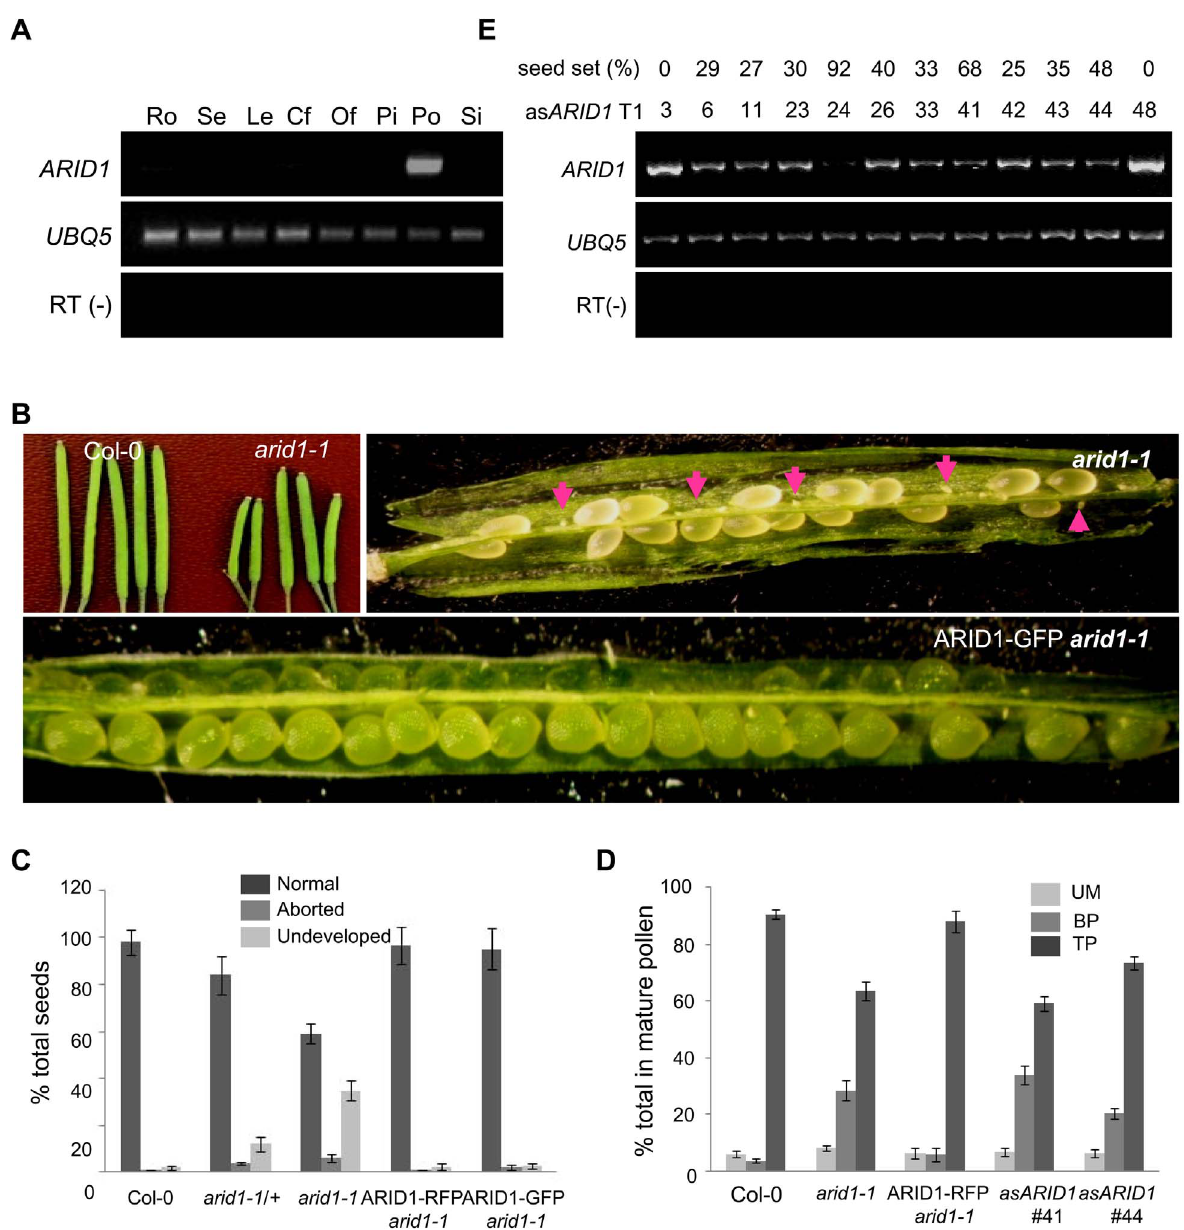
Figure 1. Specific expression of ARID1 in pollen and disruption of ARID1 results in defective sperm cell formation. (A) Expression of ARID1 by RT-PCR. Ro, roots; Se, seedlings; Le, leaves; Cf, closed flower buds; Of, open flowers; Pi, unpollinated pistils; Po, mature pollen; Si, siliques. The RT ( 2 ) control PCR was performed with UBQ5 primers. (B) Representative siliques of WT and arid1-1 and complementation test. Undeveloped ovules are indicated with arrows. (C) Percentage of normal seeds (dark grey), aborted seeds (lighter grey), and undeveloped ovules (lightest grey) from self-pollinated plants are shown. Error bars represent standard deviation from the mean. (D) Seed set analysis in antisense ARID1 transgenic plants. Numbers in the bottom row represent individual T1 lines, and the corresponding numbers in the top row indicate the percentage of reduced seed set in each line. The gel shows the expression of ARID1 as assessed by RT-PCR analysis. (E) Distribution of unicellular microspores (UM, lightest grey), bicellular pollen (BP, lighter grey), and tricellular pollen (TP, dark grey) in mature anthers. At least 600 pollen grains were stained with DAPI and used for statistical analysis; Error bars represent standard deviation from the mean. expression of these genes was disturbed in arid1-1 . Of these, only in both bicellular pollen (Figure 2B, upper panels, yellow arrows) and mature pollen (Figure 2B, lower panels, yellow arrows). Since DUO1 mRNA levels were reduced in arid1-1 (Figure 2A), suggesting that ARID1 positively regulates DUO1 at the DUO1 is one of the targets of miR159 [12], we examined transcriptional level, either directly or indirectly. DUO1 expression MIR159 expression in the arid1-1 mutant by qPCR, but found no was also reduced in the antisense ARID1 plants with reduced seed change in miR159 levels (Figure S2B). As we recently showed that set (Figure S2A). We also crossed a DUO1-RFP reporter into Anaphase Promoting Complex 8 (APC8) is involved in CYCB1 regulation at both the transcriptional level and protein degrada- arid1-1 and saw that the DUO1-RFP signal was slightly reduced,